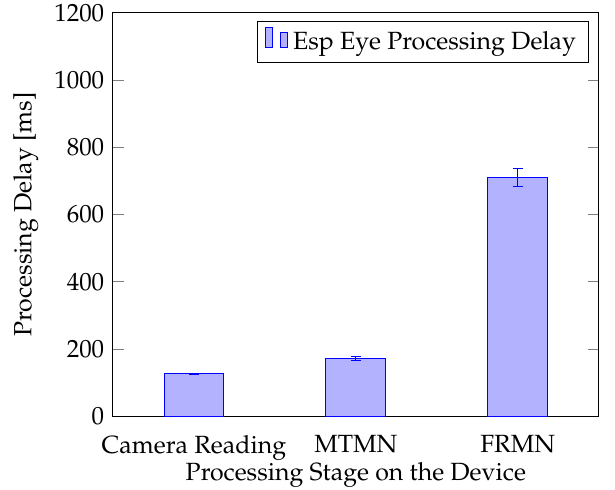
Figure 8. Esp Eye Processing Delay When a Face is Detected in Front of the